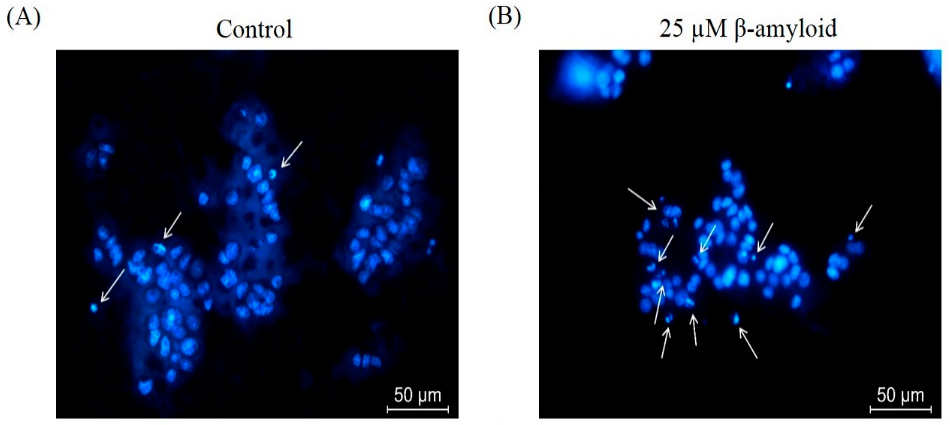
Figure 3. Cont . Figure 3. Cont .